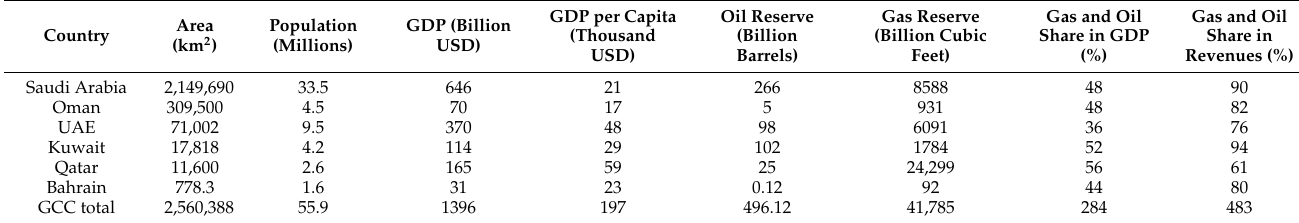
Table 1. GCC countries’ details [28,29].